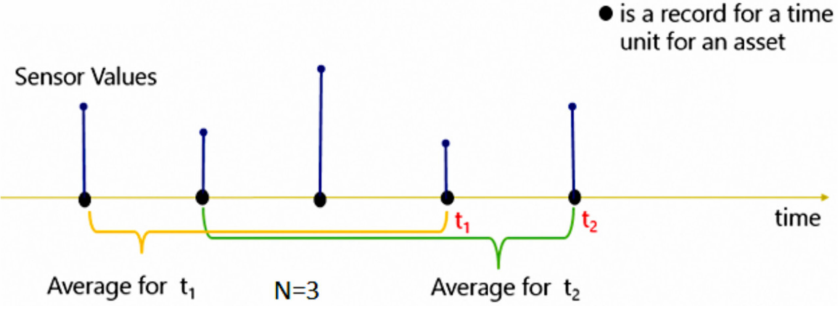
Figure 7. Lag Features [9].